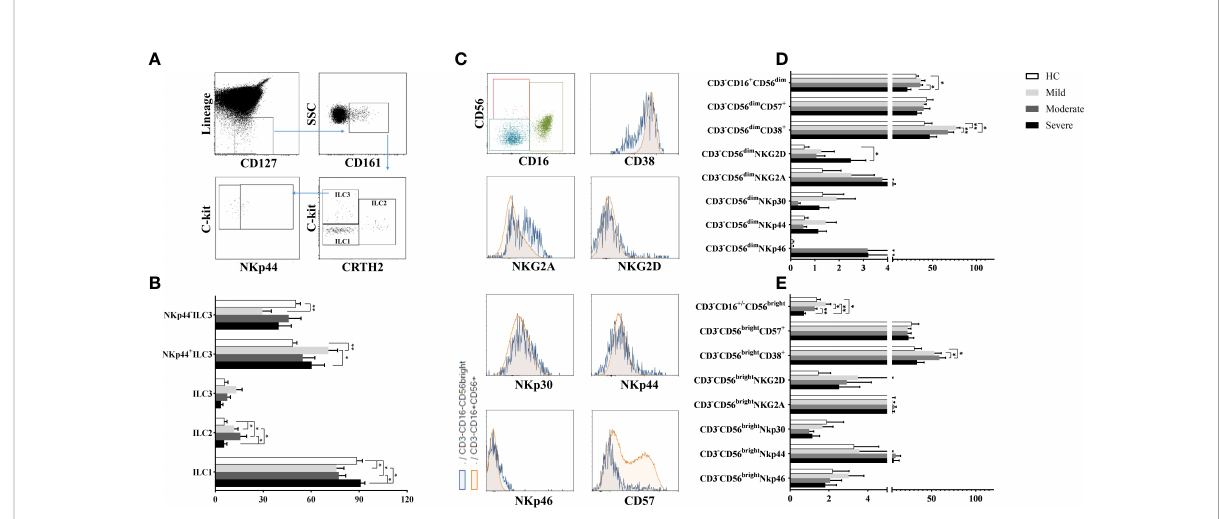
FIGURE 1 The evaluation of ILC and NK cell ratios of patients with COVID-19. (A) The gating strategy of ILC subsets were shown in the representative fi gure. Lineage - CD127 + cells were gated in CD45 + viable lymphocytes, and CD161 + cells were chosen as total ILCs. Total ILCs were divided into ILC2 and ILC3 subsets based on CRTH2 and c-Kit expression. (B) The frequencies of ILC subsets in patient groups and healthy controls were shown. (C) The gating strategy of NK cell subsets (CD3 - CD16 + CD56 dim and CD3 − CD16 -/+ CD56 bright NK cells were gated in CD3 − cell population) and the expression of NK cell receptors/surface molecules were shown in the representative fi gure. (D) The expression levels of CD38, CD57 and NK cell receptors in CD3 − CD16 + CD56 dim and (E) CD3 − CD16 -/+ CD56 bright NK cells were demonstrated in patient groups and healthy controls. *p<0.05, **p<0.001, HC, Healthy